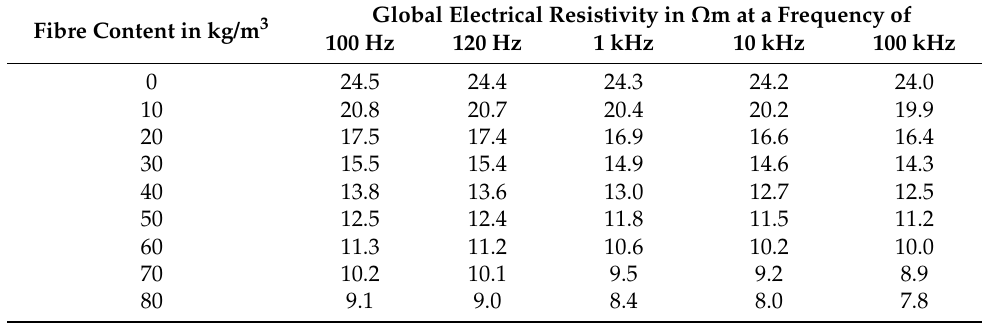
Table A33. Results of the resistivity measurements of the concrete mixture 52-60-330-35.